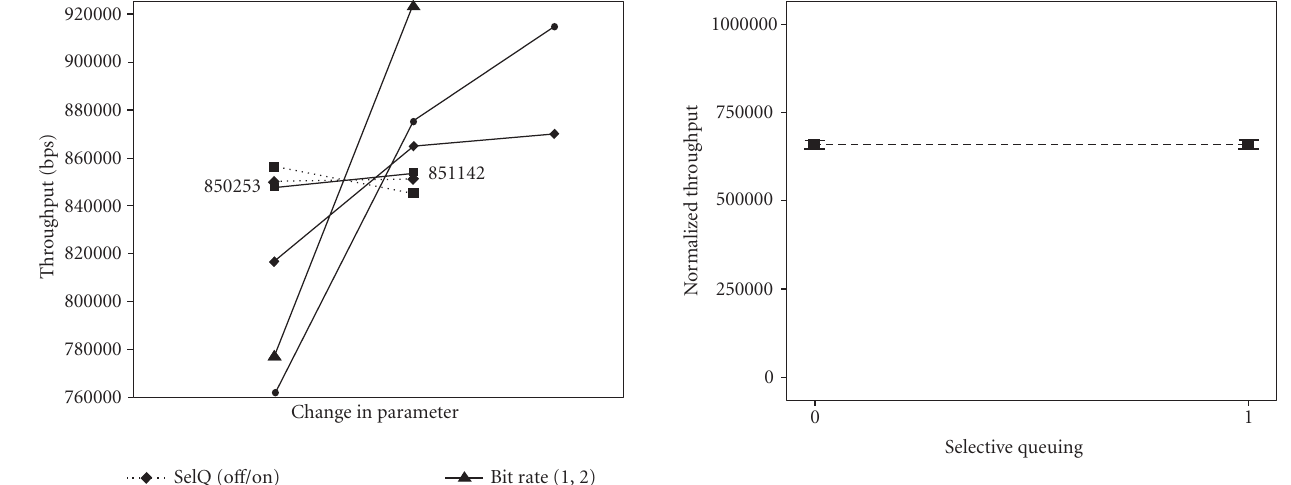
Figure 13: Analysis of selective queuing’s impact on FTP through- put.